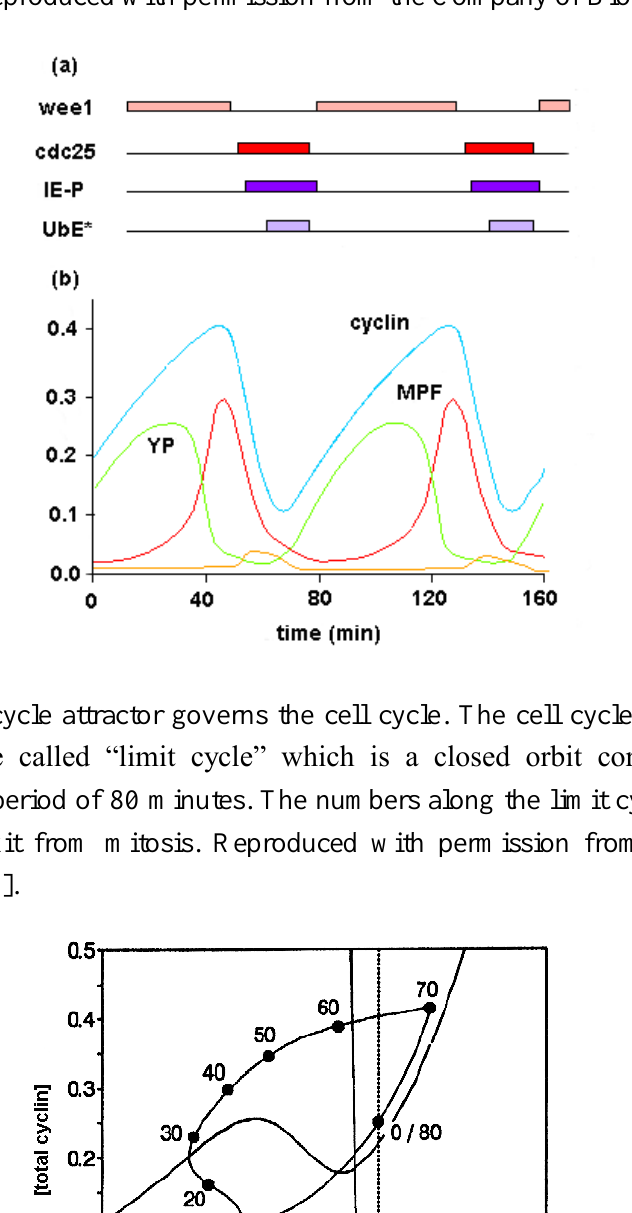
Figure 3. Quantitative analysis of the M-phase control system showing spontaneous periodic oscillations in the metabolic intermediaries. The total cyclin concentrations (blue), active form of MPF (red), tyrosine-phosphorylated dimers, YP, (green) and total phosphorylated cdc2 monomers (orange) are represented as a function of the time in minute. The bar graphs indicate the periods during which the active forms exceed 50% of the total amount. Reproduced with permission from the Company of Biologists Ltd. [218].